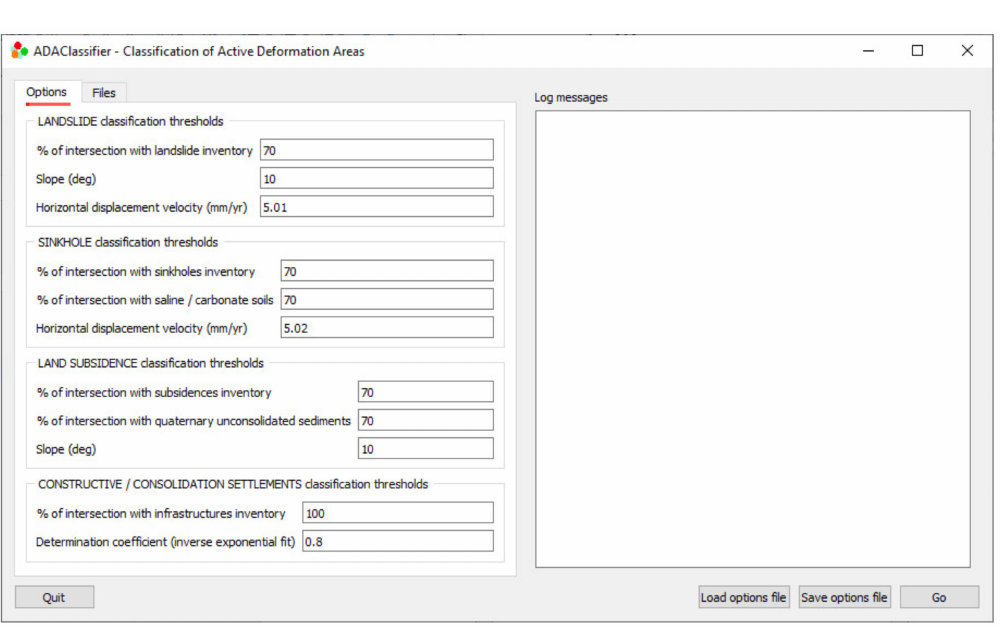
Figure 4. The ADAclassifier GUI (options